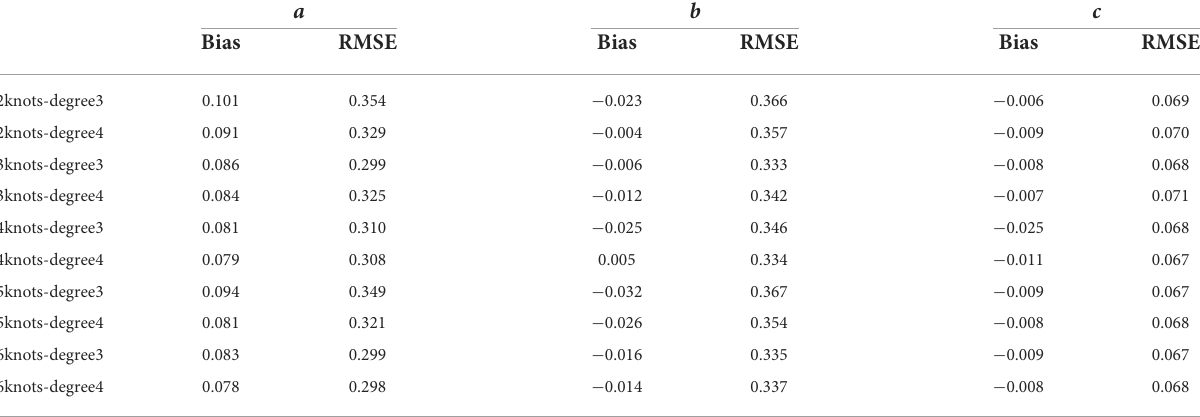
TABLE 2 Bias and RMSE of item parameter estimates under different combinations of knots and degree in normal case.